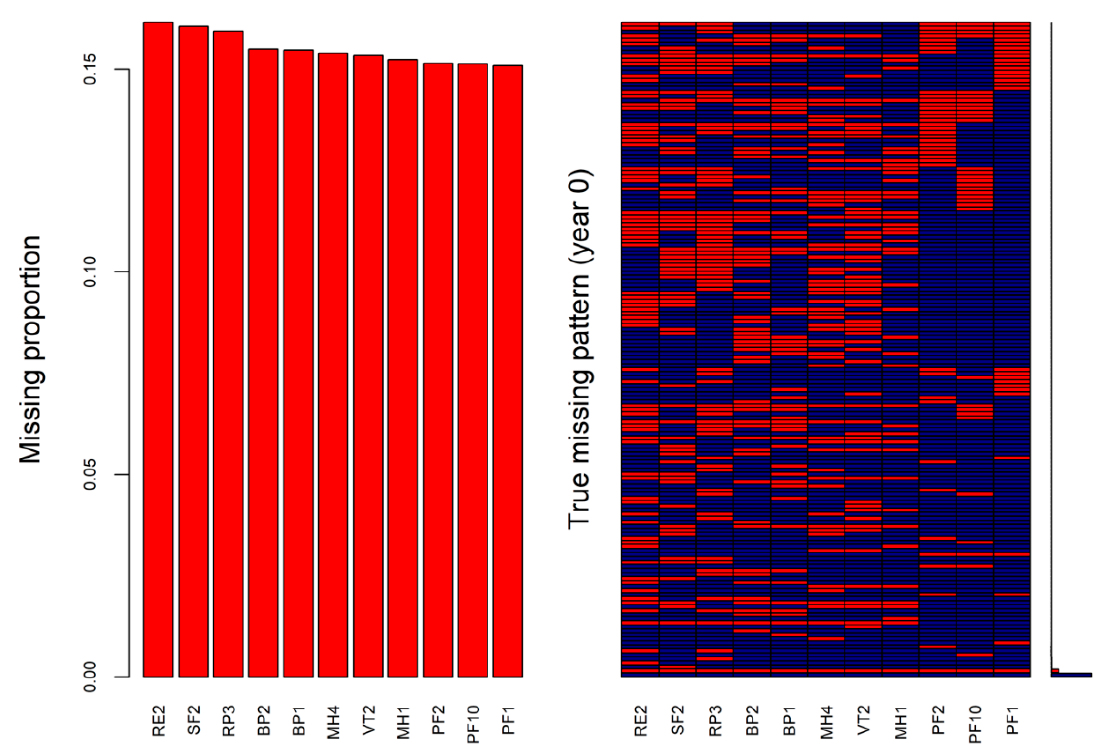
Figure 1. Missing proportions ( left ) and missingness patterns ( right ) of the selected 11 SF-36 items at baseline in the real-world data (red cells indicating missing). BP, bodily pain; MH, mental health; PF, physical function; RE, role-emotional; RP, role participation; SF, social function; VT, vitality.